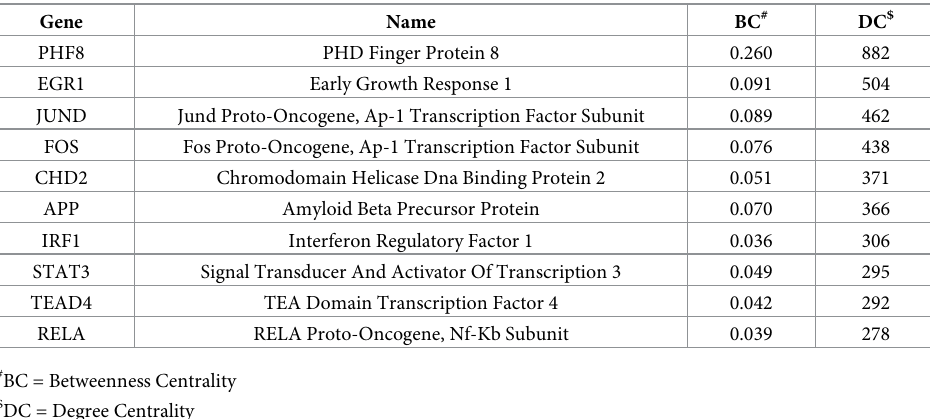
Table 1. List of 10 significant genes obtained from network analysis based on graph theory.